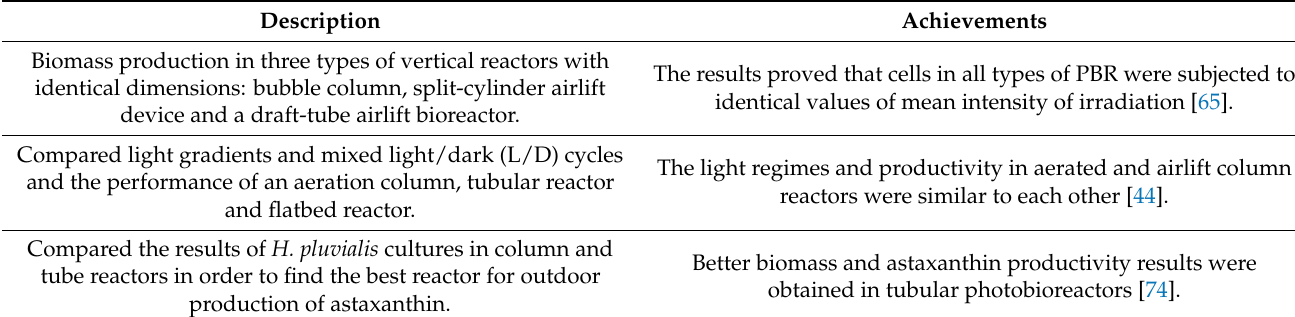
Table 7. Mode of operation, parameters and efficiency of various types of photobioreactors—main